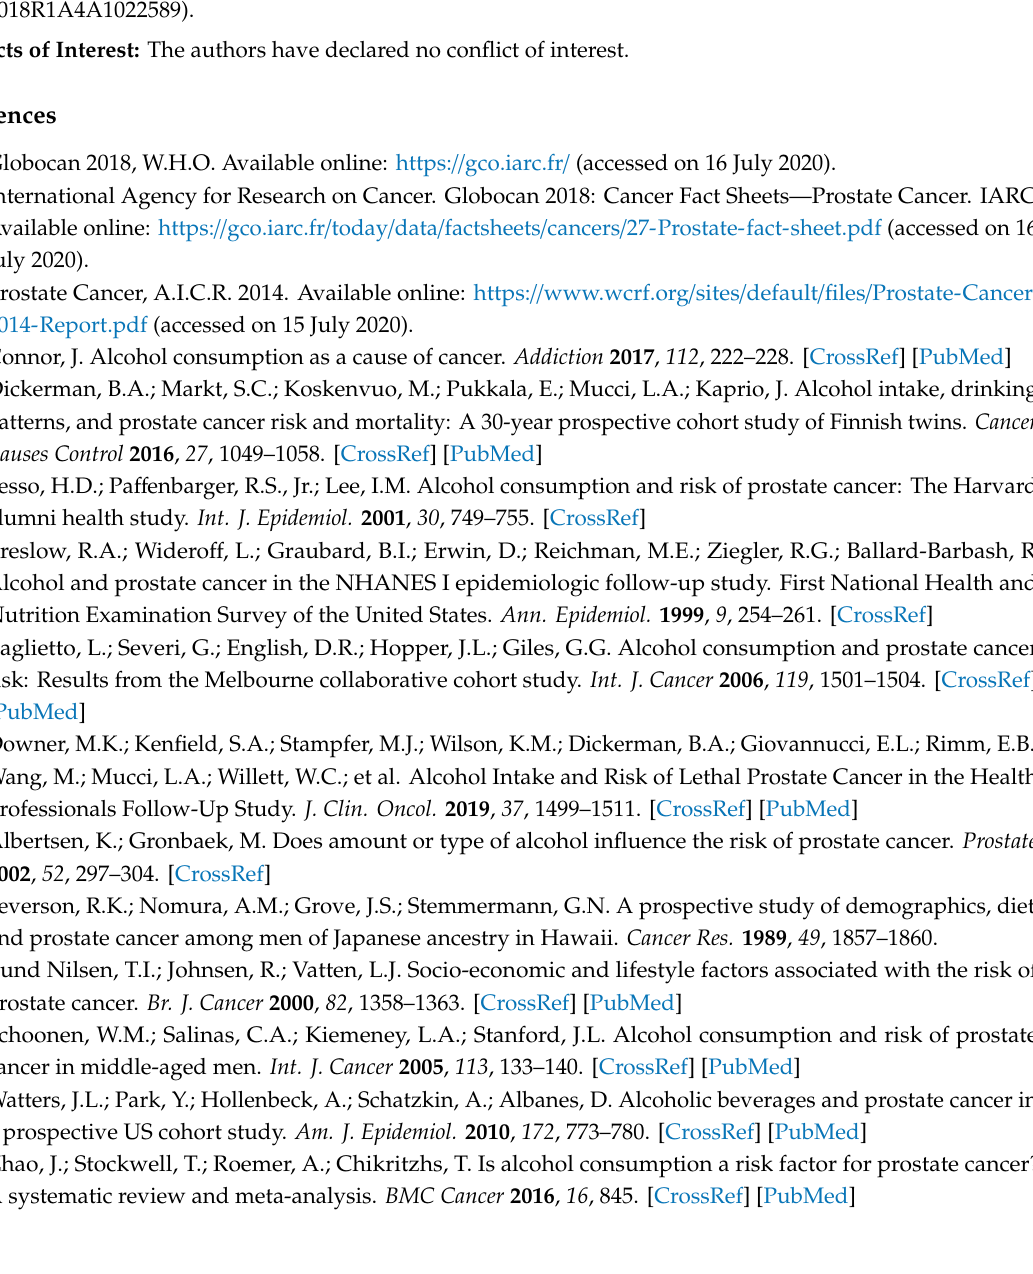
Table S1: Database search strategy, Table S2: Characteristics of studies included, Table S3: MOOSE Checklist, Figure S1: Subgroup analyses for alcohol intake by types and prostate cancer risk by types, Figure S2: Sensitivity analyses for total alcohol intake and prostate cancer risk, Figure S3: Sensitivity analyses for wine intake and prostate cancer risk, Figure S4: Sensitivity analyses for beer intake and prostate cancer risk, Figure S5: Sensitivity analyses for liquor intake and prostate cancer